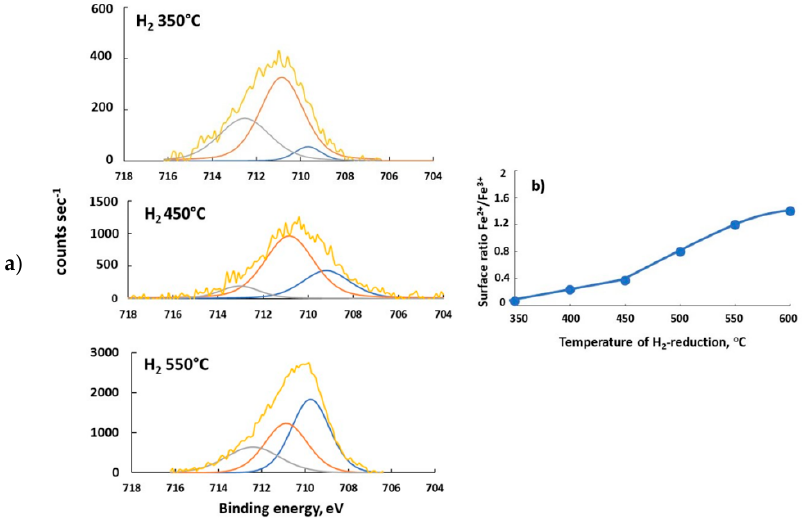
Figure 11. XPS spectra of 6%BaFeHAl-30 catalyst after reduction at 350, 450, and 550 °C Fe 2+ , F 3+Oh , Fe 3+Th ( a ); effect of reduction temperature on the surface Fe 2+ /Fe 3+ ions ratio calculated based on XPS spectra deconvolution ( b ).